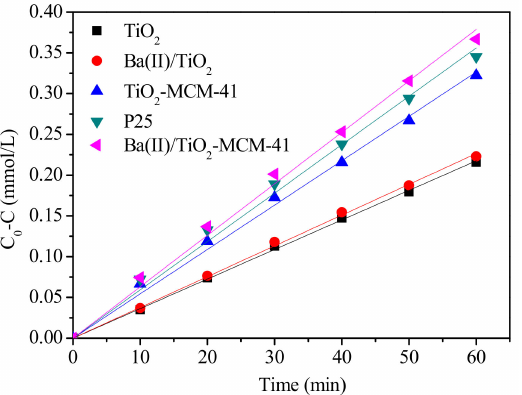
Figure 8. Zero order models for the photodegradation of p-nitrobenzoic acid by various photocatalysts. Table 2. Reaction rate constant (k) and correlation coefficient (R 2 ) of various photocatalysts.